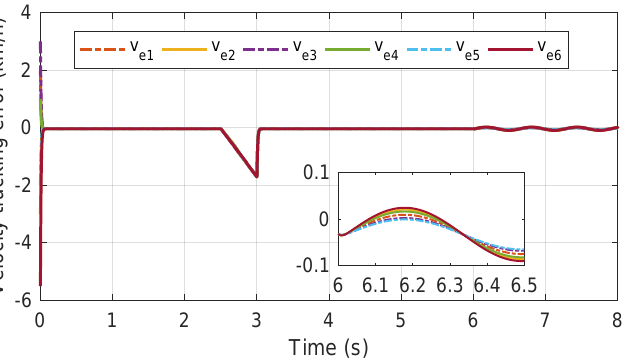
Figure 15. Velocity tracking error curve of each carriage with the proposed observer-driven consensus braking control strategy in case